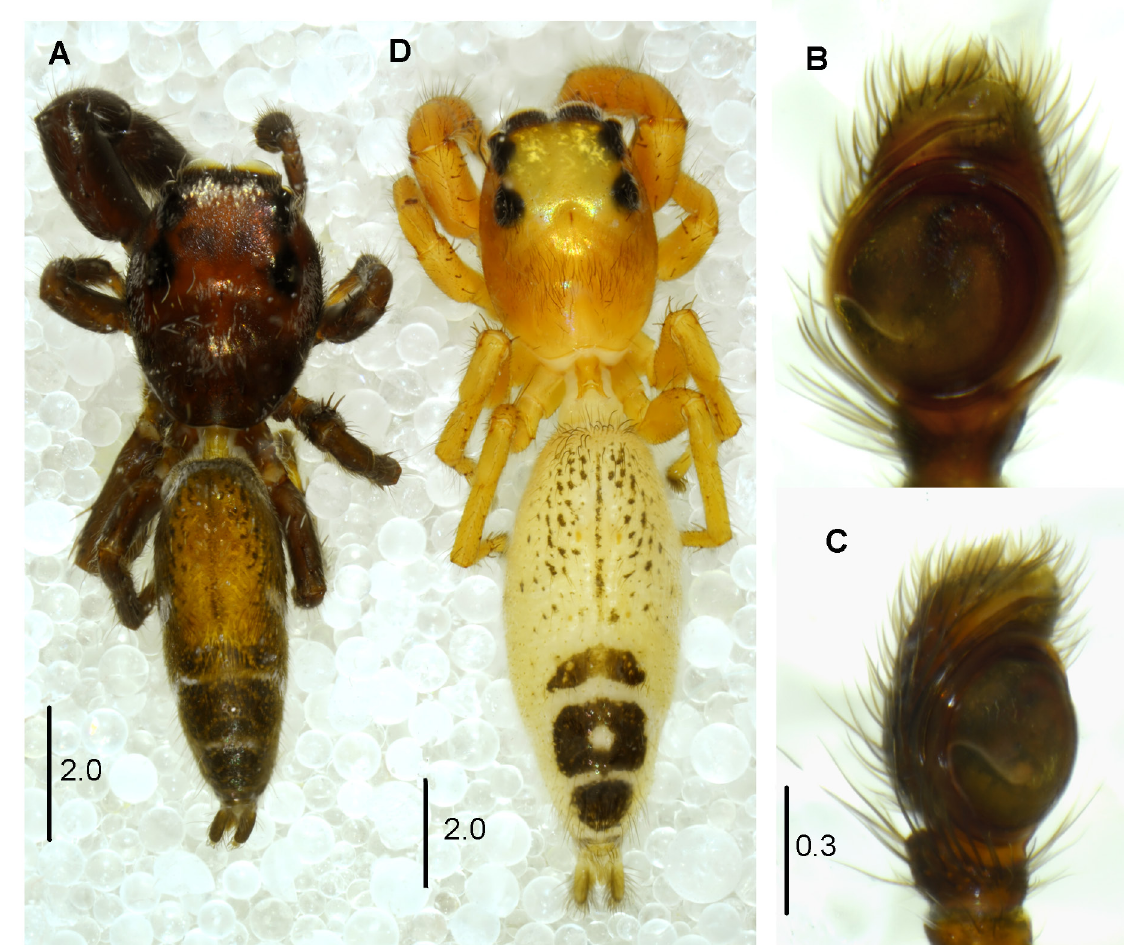
Fig. 70. Thyene aperta (Peckham & Peckham, 1903), ♂♀ (MNHN). A . Habitus of male, dorsal view. B . Palpal organ, ventral view. C . Palpal organ, ventroprolateral view. D . Habitus of female, dorsal